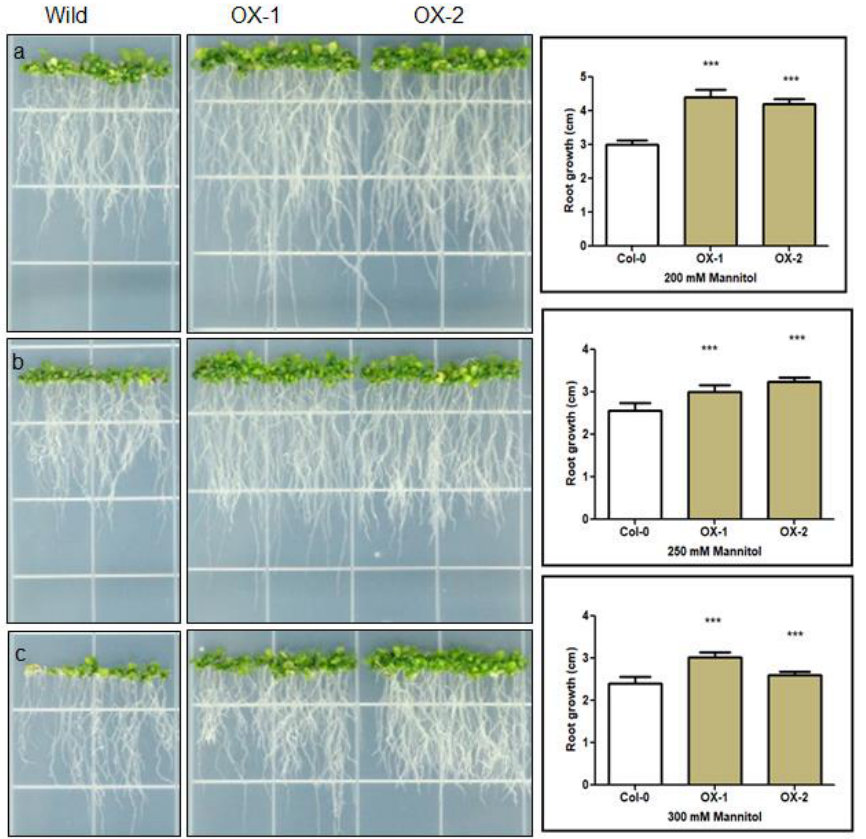
Figure 2. Comparison of root phenotypes of transgenic Arabidopsis lines overexpressing BrEXLB1 (OX-1 and OX-2) and wild (Col-0) in the presence of 200 mM ( a ), 250 mM ( b ), and 300 mM of D-Mannitol ( c ) in Murashige and Skoog (MS) agar plates for 17 consecutive days (*** represents statistical significance).